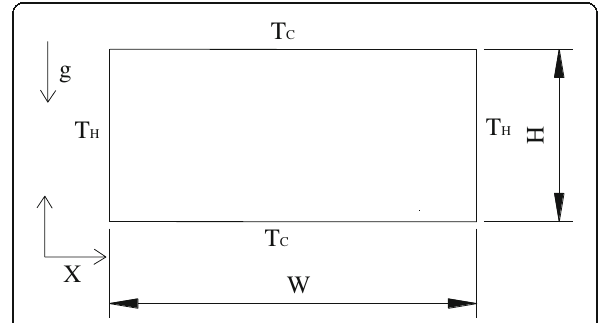
Fig. 1 Rectangular enclosure. The left and right walls of the rectangular enclosure keep a high temperature T H , and the top and bottom walls keep a low temperature T C . The width and height of the rectangular enclosure are W and H respectively